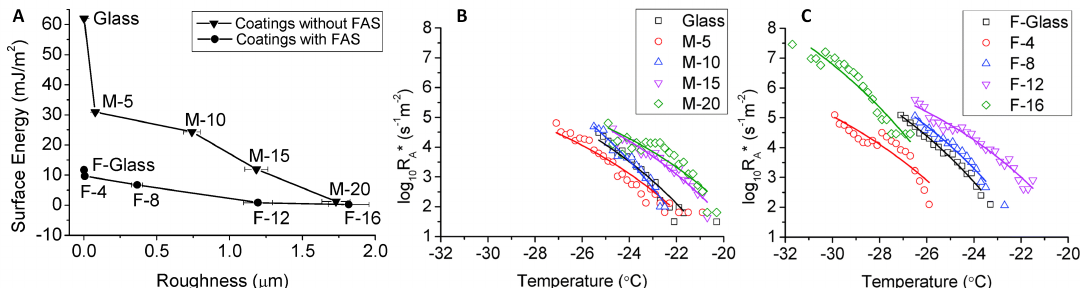
Figure 4. ( A ) Shows values for surface energy and roughness for two differing types of samples, with and without fluoroalkylsilane (FAS). Both samples are additionally loaded with silica nanoparticles. For M-x and F-x, x denotes the weight % of silica nanoparticles and FAS respectively; ( B , C ) Show variations in the area nucleation rate with temperature for the non-fluorinated and fluorinated samples. Reprinted with permission from Ref. [46]. c (cid:13) 2015 Royal Society of Chemistry.